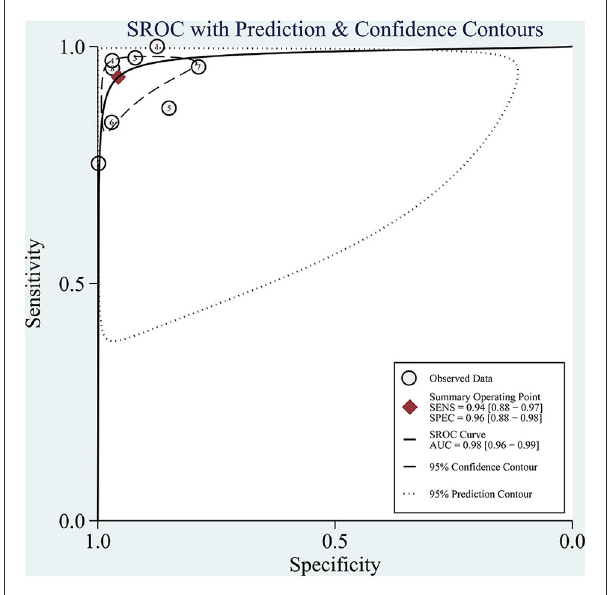
FIGURE5 sROC curves for the diagnosis of CAG using AI. Each circle indicates an individual study, red diamond represents summary sensitivity and specificity.